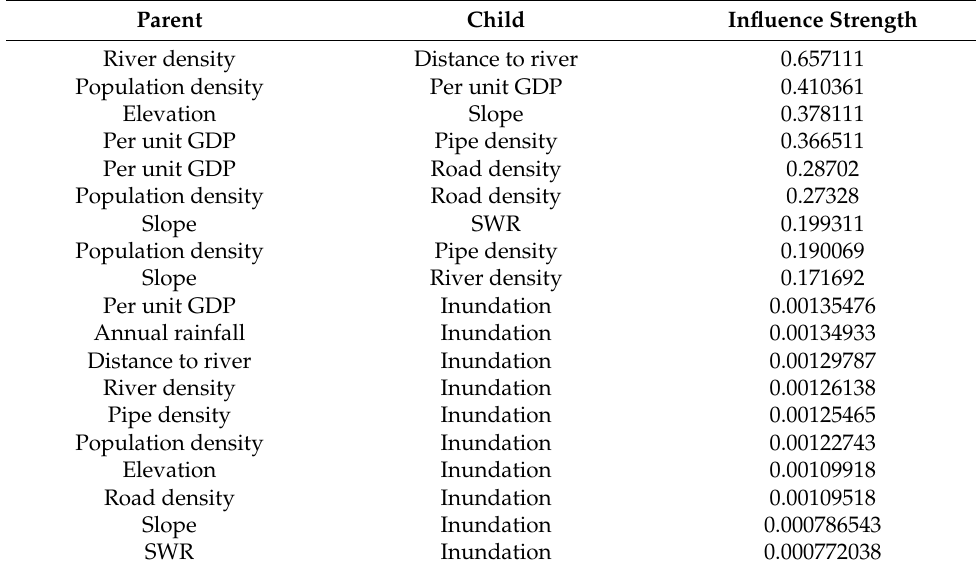
Figure 7. Influence strengths and three key disaster-causing factors chains. Table 3. Influence strengths between all parent and child